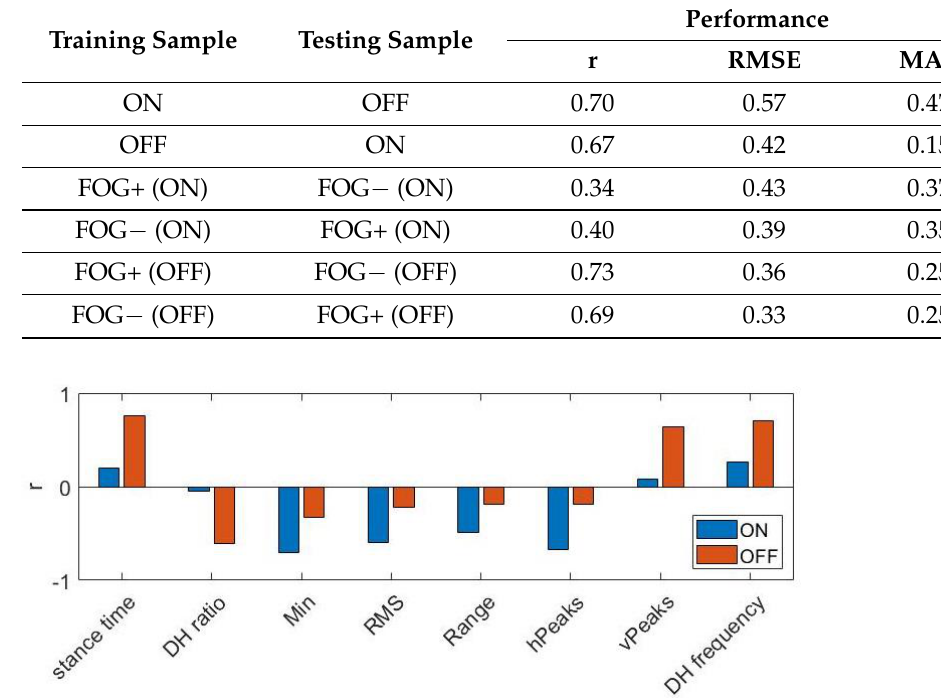
Figure 11. Pearson correlation coefficient between features and PIGD score. DH ratio and DH frequency refer to the component θ x ; Min and vPeaks refer to the component ω x ; RMSE and Range refer to the component α y